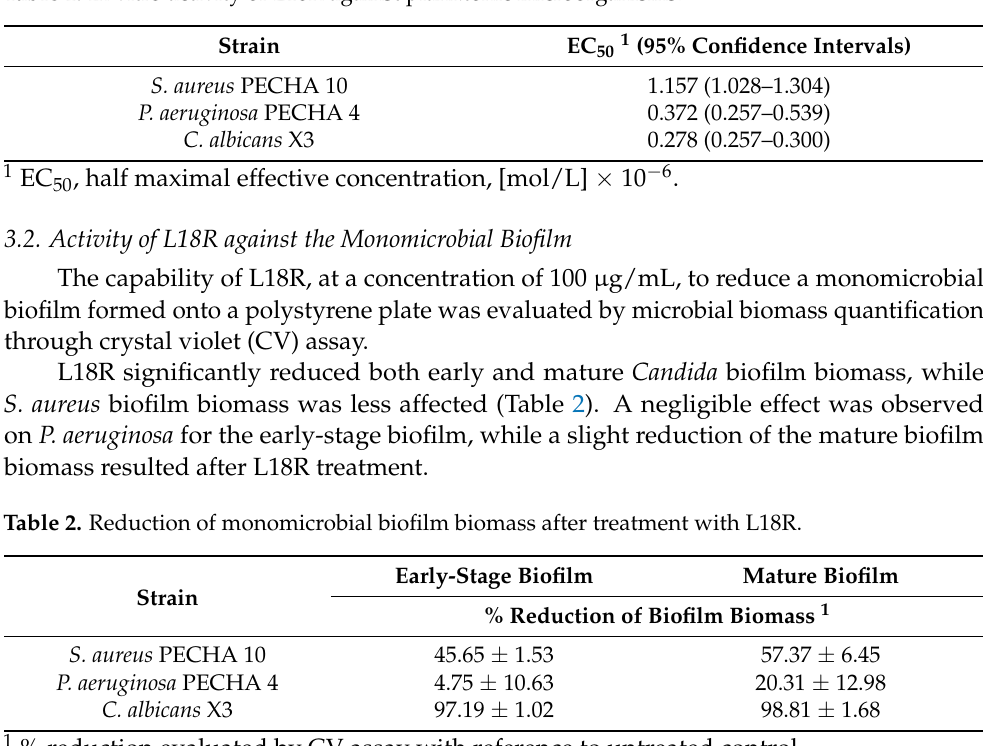
Table 1. In vitro activity of L18R against planktonic microorganisms.